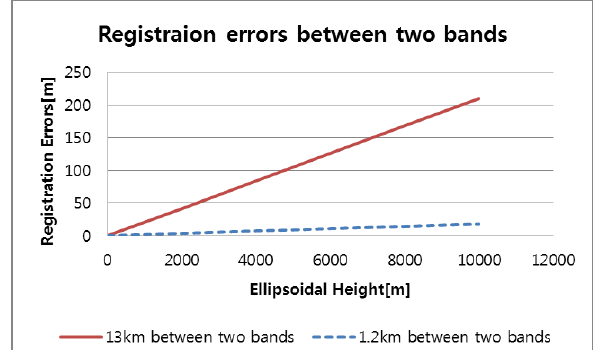
Figure 1. Registration errors between two bands with different look angle